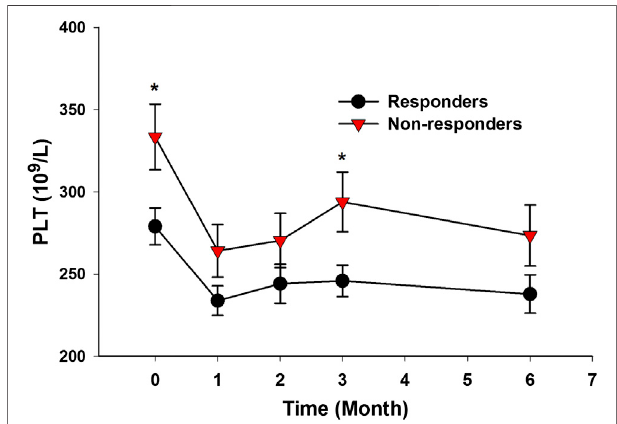
FIGURE 5 | AS patients with good response to anti-TNF- α therapy had lower platelet count. (Responders to anti-TNF- α therapy had signi fi cantly lower platelet count at baseline and at 3 months after treatment (* p <